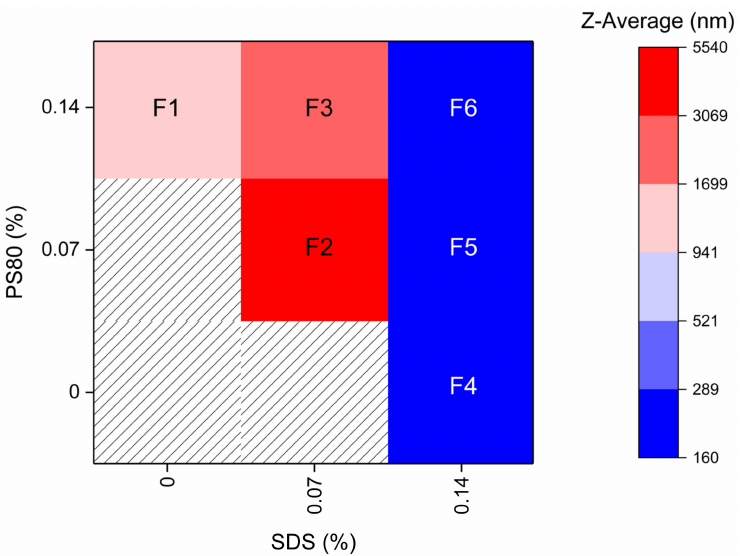
Figure 1. Z-average after 8 h of milling with different stabilizer solutions. Composition is given in % ( w / w ) and HPC-SL concentration was kept constant at 0.9%. Milling was carried out at 4 ◦ C with 1500 rpm and milling beads sized 0.3–0.4 mm. Hatched area: No stable nanosuspension was obtained. Values are given as mean of three